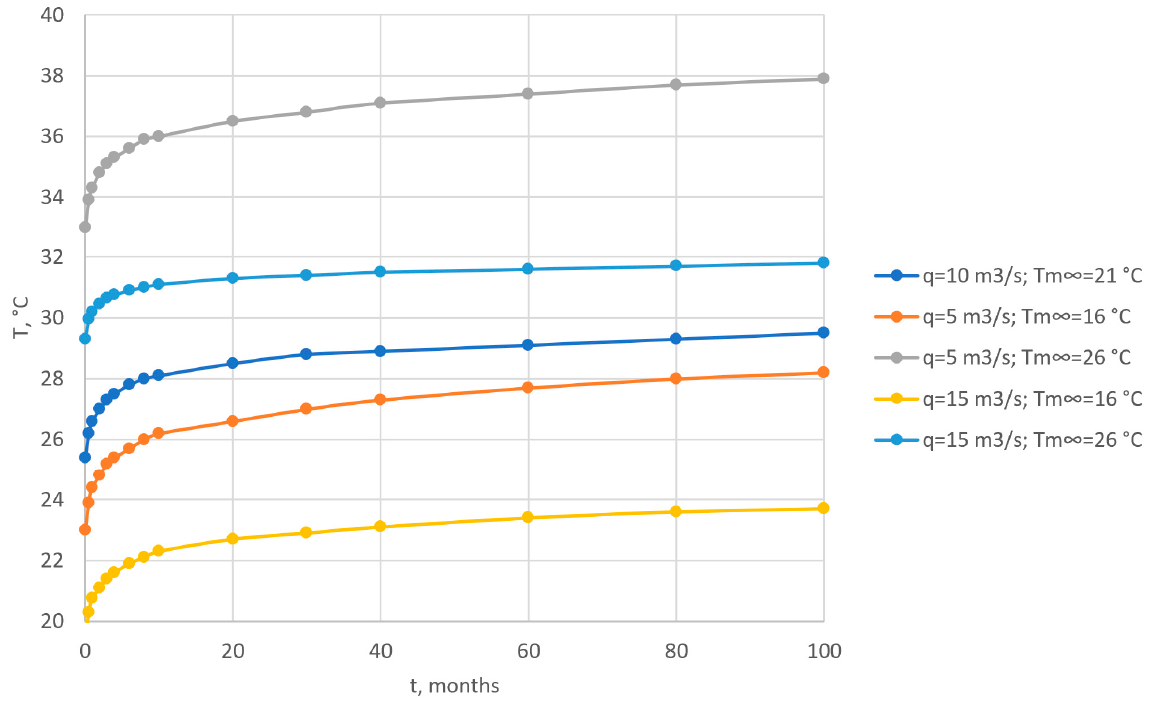
Figure 3. Air temperature at the end of the conveyor roadway vs. time.